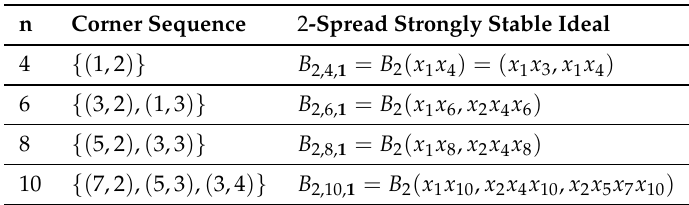
Table 2. Corner sequences for n =